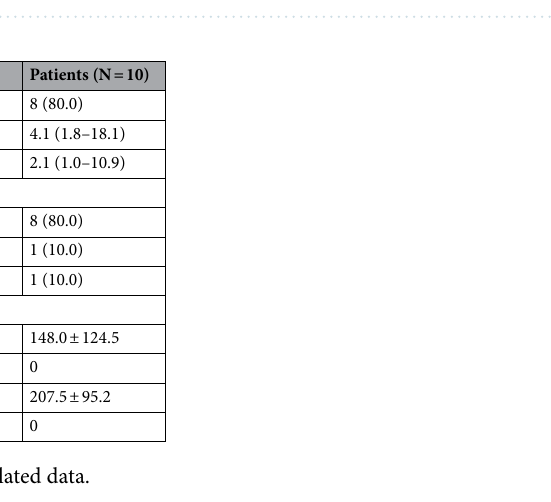
Figure 1. Computed tomography scan of a 4-year-old male patient with neuroblastoma ( a ), 3D reconstruction ( b ), and 3D printed model.